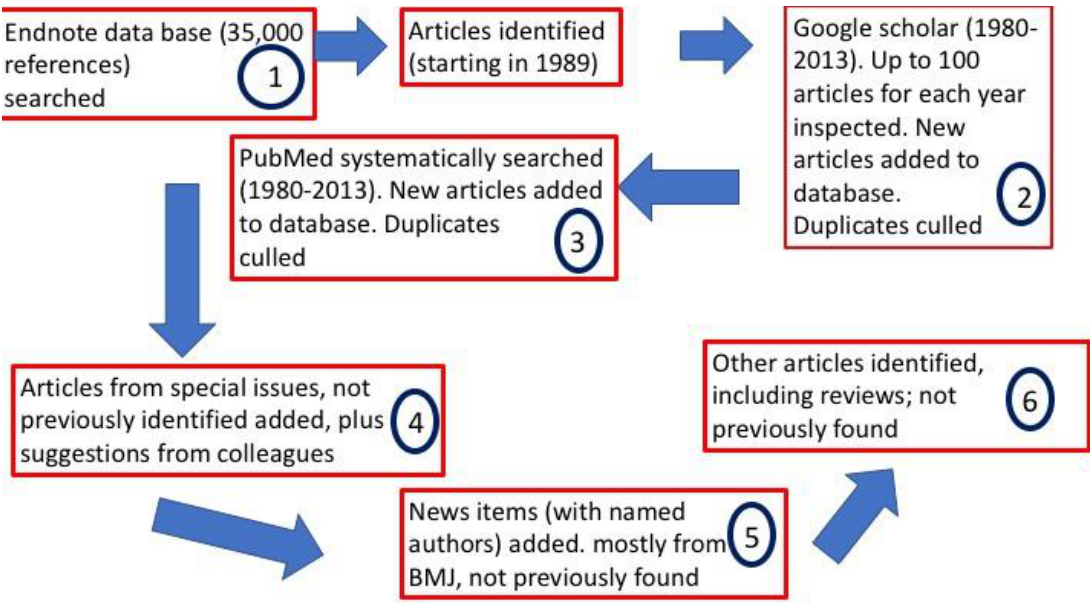
Figure A1. Outline of the six stage search strategy for papers published from 1989–2013.